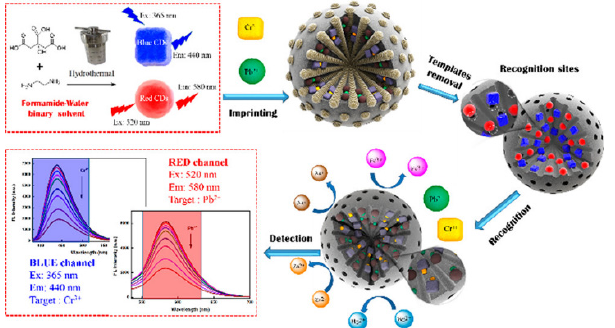
Figure 7. Schematic illustration of the preparation process and simultaneous detection of Cd 2+ and Cu 2+ using CD-incorporated ion-imprinted fluorescent polymers. Reproduced with permission from [101]. Copyright (2019) American Chemical Society.